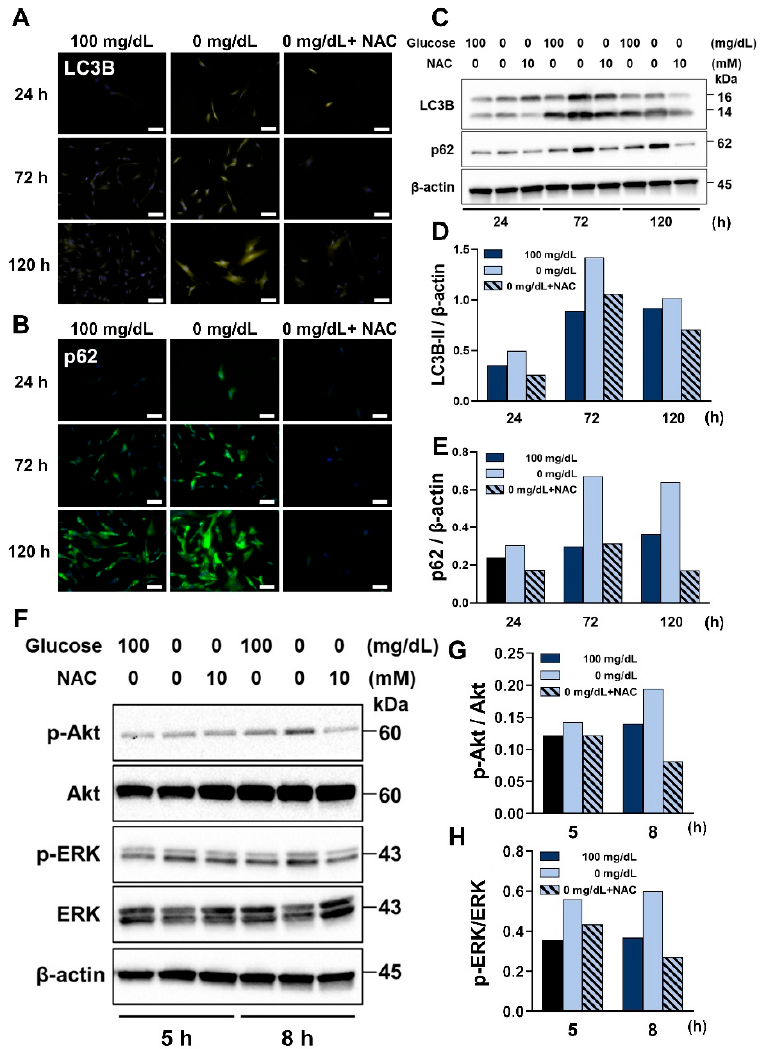
Figure 6. NAC prevented the induction of autophagy in the HGnFs under low glucose conditions and inhibited the phosphorylation of the ROS-Akt/ERK signaling pathway. ( A , B ) Synthesis of autophagy-related proteins (Total-LC3B and p62) in the HGnFs after 24, 72, and 120 h of incubation under low glucose conditions following the addition of NAC. The nuclei were stained with DAPI. ( C – E ) LC3B and p62 expression were analyzed using western blot, performed on protein extracts from these cells with antibodies against the described proteins and β -actin serving as a loading control. ( F – H ) The protein expression of the ROS-Akt/ERK signaling pathway was evaluated using western blotting analysis and quantified using ImageJ. Western blot analysis was performed on protein extracts of these cells with antibodies against the indicated proteins and β -actin as a loading control. The samples derived from the same experiment and the gels/blots were processed in parallel. The expression levels of Akt, p-Akt, ERK, and p-ERK were measured by densitometric analysis using ImageJ. (Scale bar: 100 μ m.).